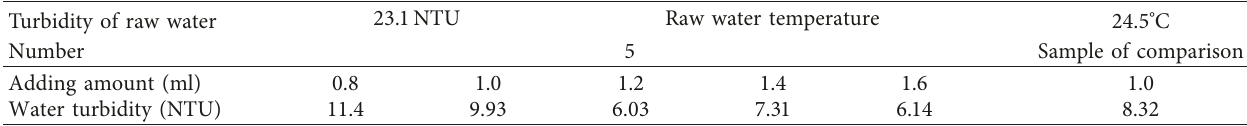
Table 7: Formula no. 5 treatment of tap water source water-related case.